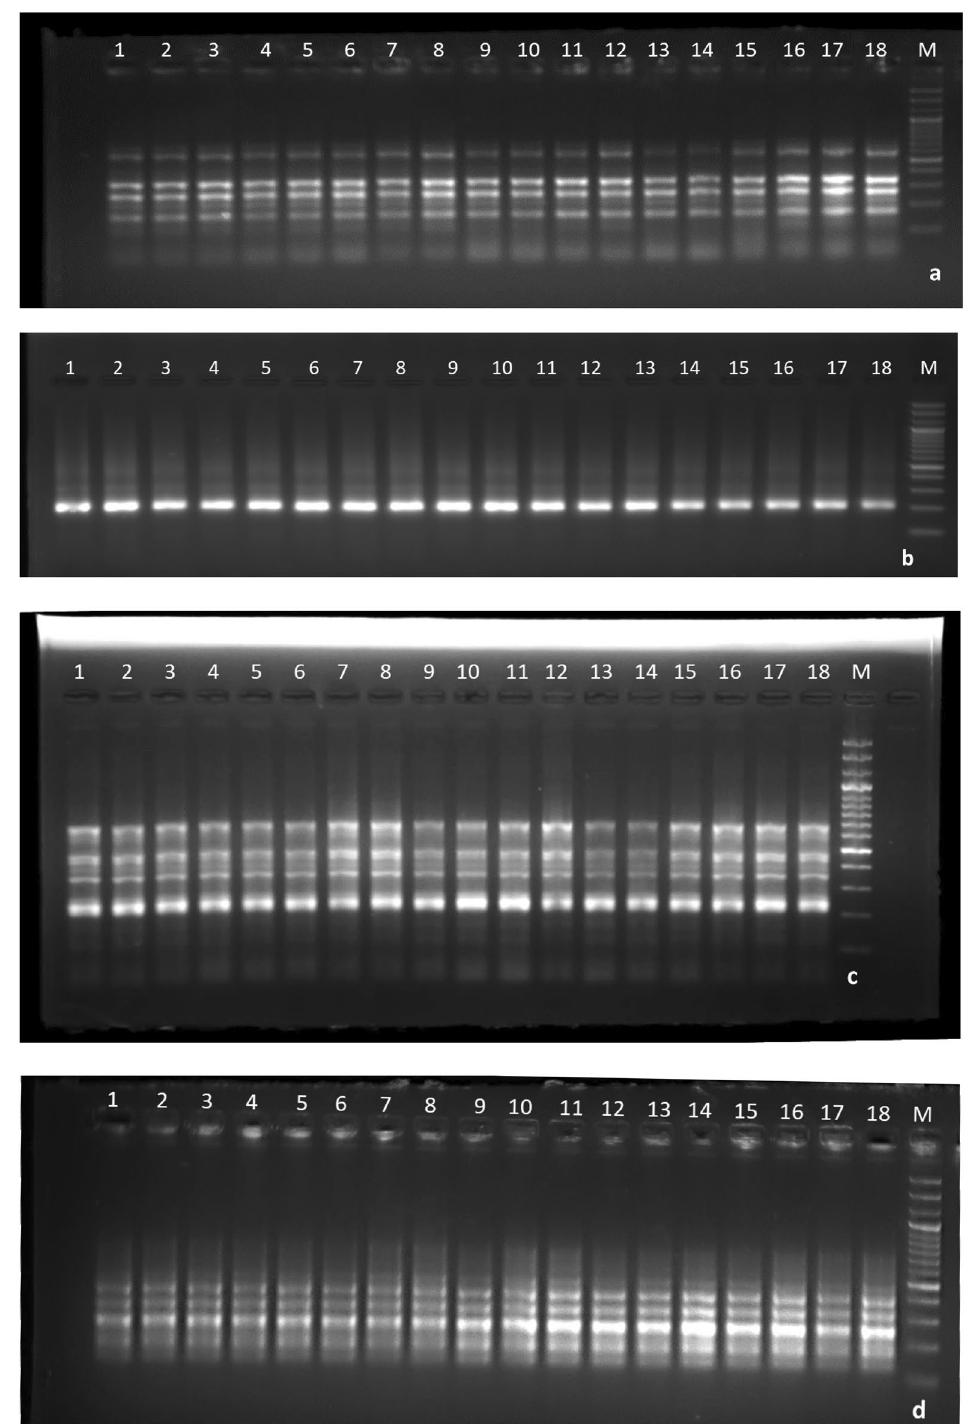
Figure 6. ISSR profile of primer ( a ) UBC848, ( b ) UBC858, ( c ) UBC836 and ( d ) IS53 in Xanthosoma sagittifolium ; where 1–3: mother plants, 4–6: calli, 7–9: meristematic clumps obtained on MS + 0.2 mg/L BAP + 0.1 mg/L NAA, 10–12: meristematic clumps obtained on MS + 2.5 mg/L TDZ, 13–15: plantlets multiplied MS + 0.5 mg/L BAP + 0.05 mg/L NAA, 16–18: regenerated plantlets, M: 100 bp DNA